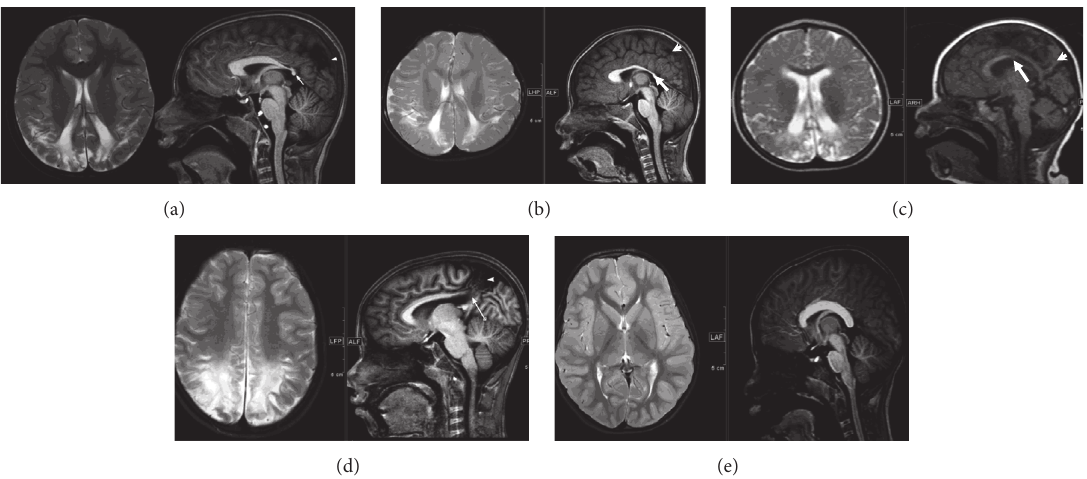
Figure 1: T2 axial and T1 sagittal MRI brain scans of the 5 children described. Cases (a)–(c)—bilateral symmetric parietooccipital gliosis (arrowhead) with regional white matter volume loss, thinning in the posterior body, isthmus, and splenium of the corpus callosum (white arrow) being evident. Associated white matter hyperintensities and ventricular dilatation are seen. Case (d)—bilateral symmetric parietal gliosis was seen (arrowhead) with marked thinning of the isthmus and splenium of the corpus callosum (long white arrow). Case (e)—a near normal scan with prominence of the atria and mild shortening of the corpus callosum and splenium, with thinning of the